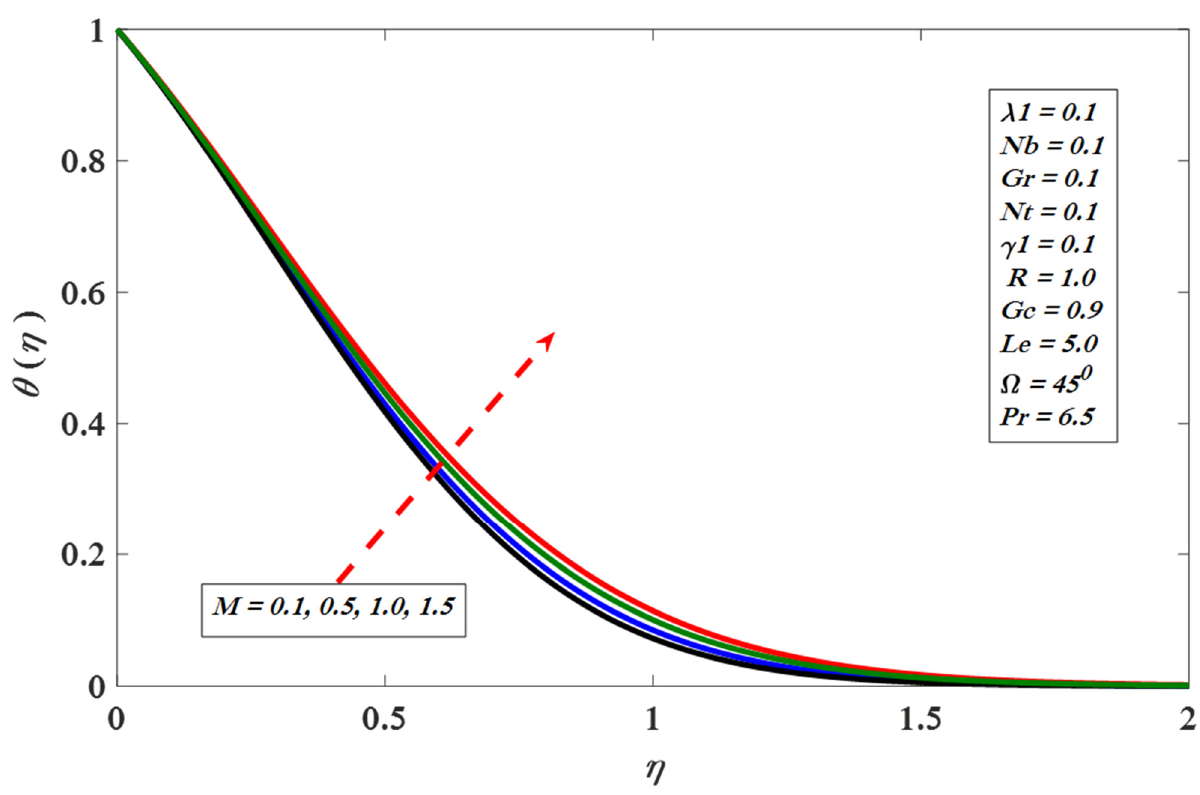
Figure 6. Velocity profile versus